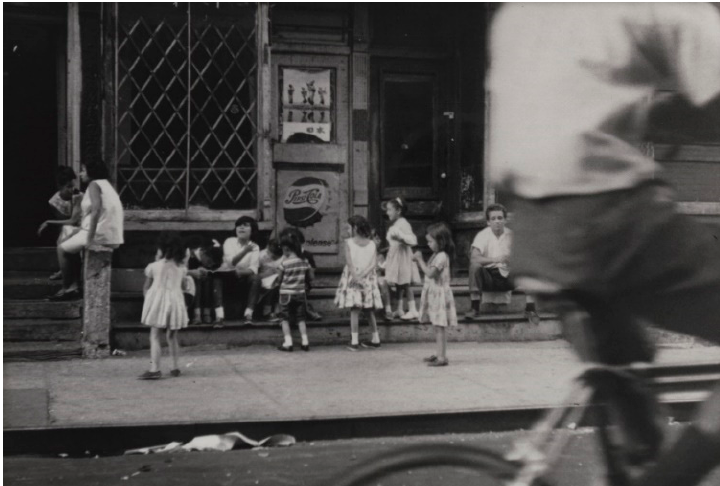
Figure 5. Martha Rosler, Untitled , from the Downtown Series , c. 1964. Gelatin silver print, 20.3 by 25.4 cm. © Martha Rosler/Courtesy of the artist and Mitchell ‐ Innes & Nash, New York.